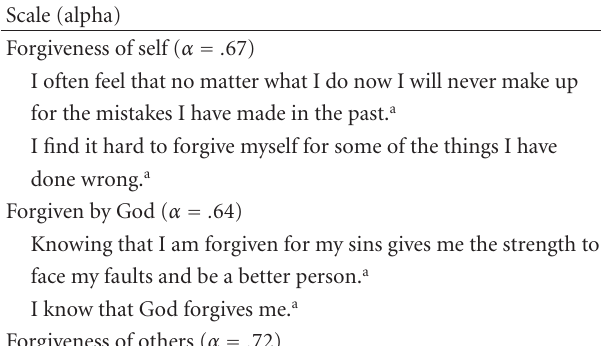
Table 1: Forgiveness scales, items, and alphas. Scale